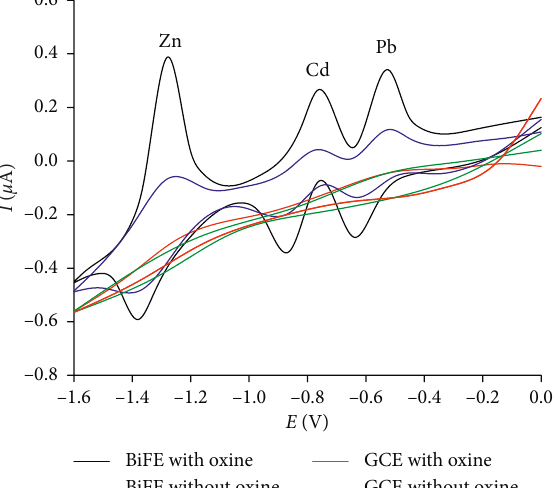
Figure 2: Cyclic voltammetric curves of Pb(II), Cd(II), and Zn(II) at GCE and BiFE with and without oxine (10ppb Pb, 10ppb Zn, and 5ppb Cd in HEPES buffer pH